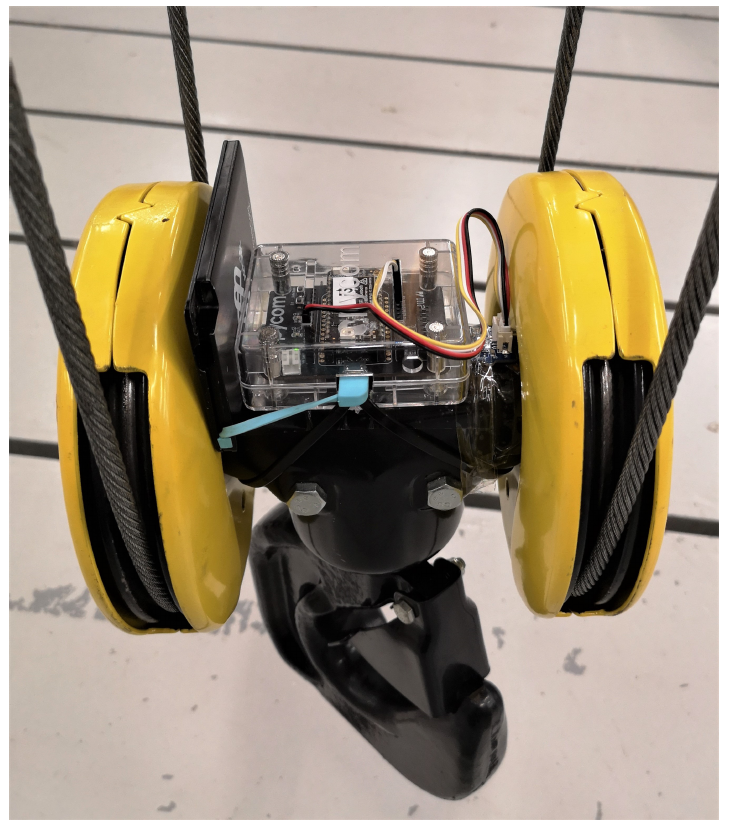
Figure 8. A three-axis accelerometer was attached to the hook of an overhead crane to estimate the usage roughness of the crane.